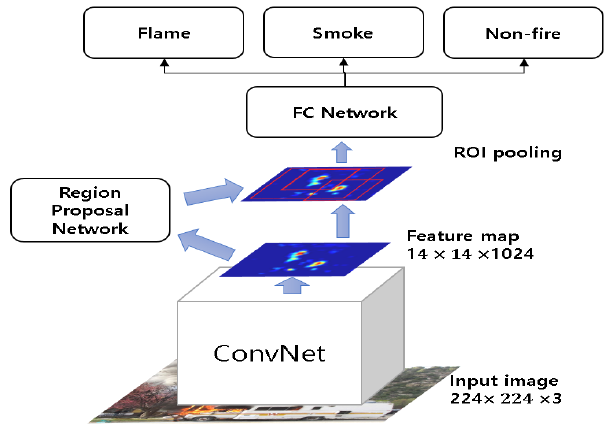
Figure 3. Faster Region-Based Convolutional Neural Network (R-CNN) structure for fire detection.